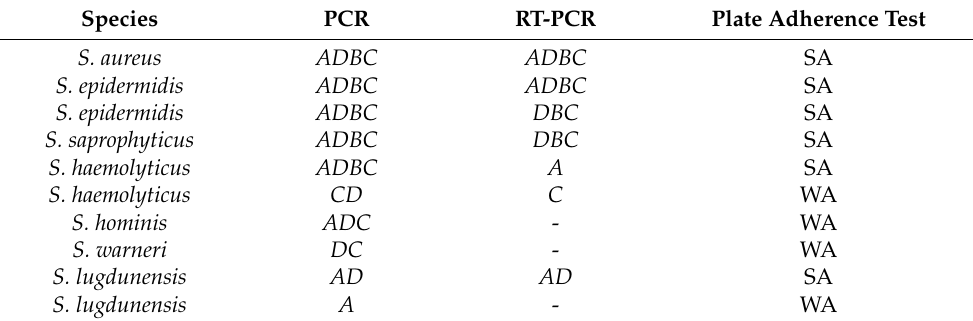
Table 2. Detection of the ica genes ( ADBC genes) gene expression analyzed using RT-PCR and biofilm formation detected by the polystyrene plate adherence method in the isolates selected for the study. Species